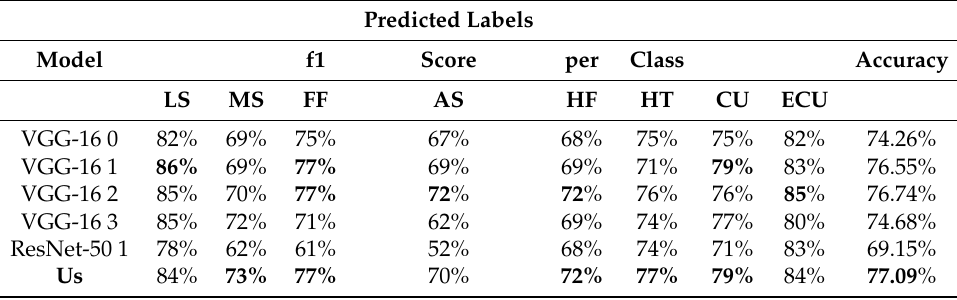
Table 7. Comparison with VGG-16 and ResNet-50.